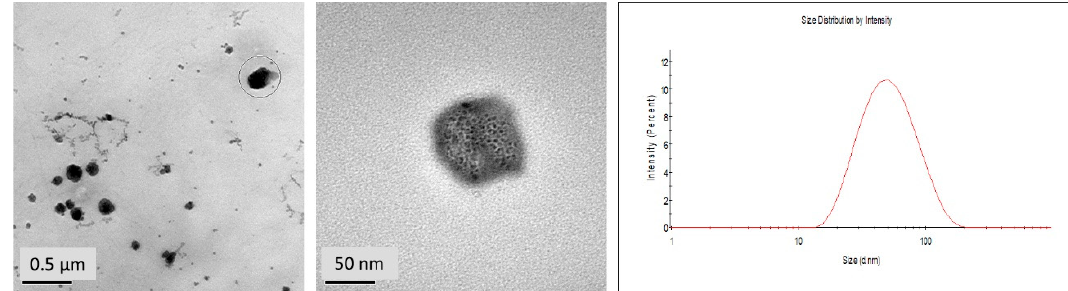
Figure 2. HR-TEM images and size distribution histogram of CUR-NP.